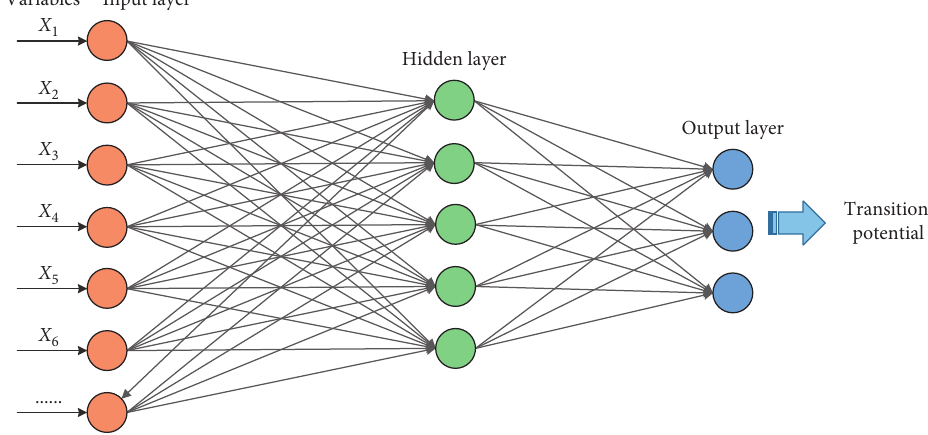
Figure 3: MLP analysis